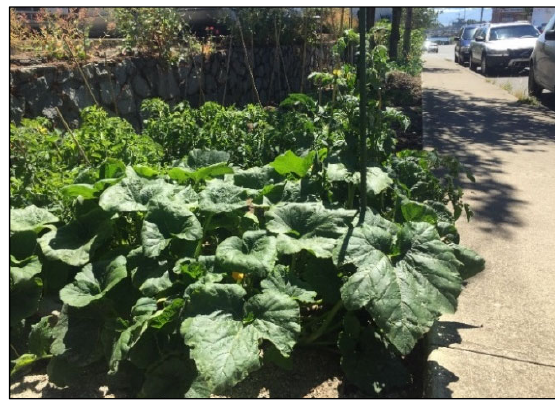
Figure 5. Food-producing Container Beds on a City Boulevard with Sidewalk